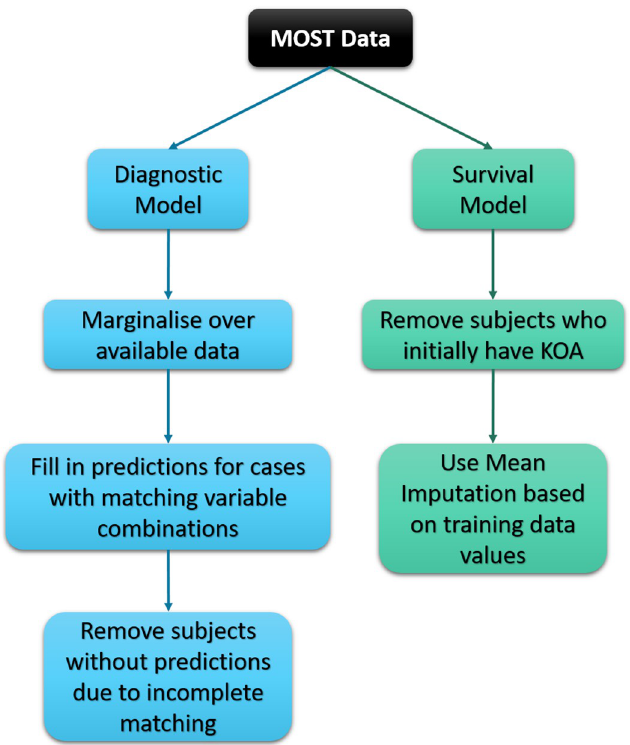
Fig 1. Missing data flowchart. A flowchart for how the missing values are dealt with in the MOST validation data.